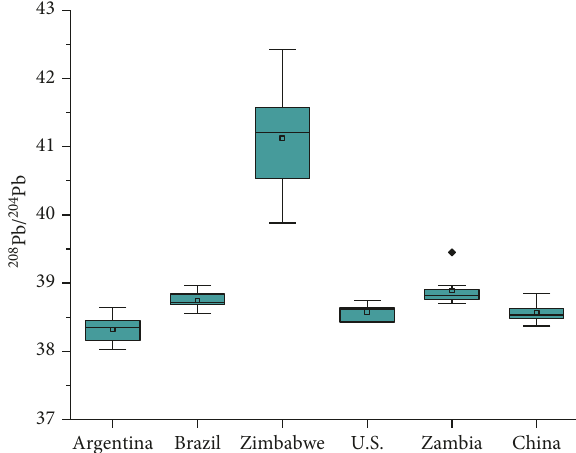
Figure 11: The box plots of 208 Pb/ 204 Pb isotope ratio in tobacco leaf from different countries in tobacco leaf from different